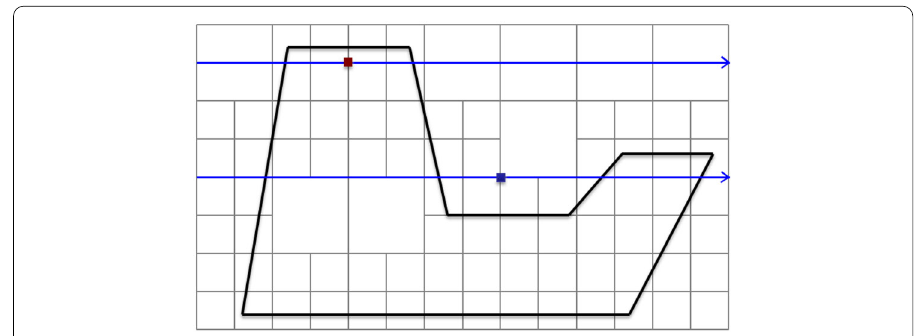
Fig. 28 Concept of ray casting to identify inside and outside of a closed geometry: Start from outside and determine the status of a given node by following the status of the ray, which changes after each intersection with the